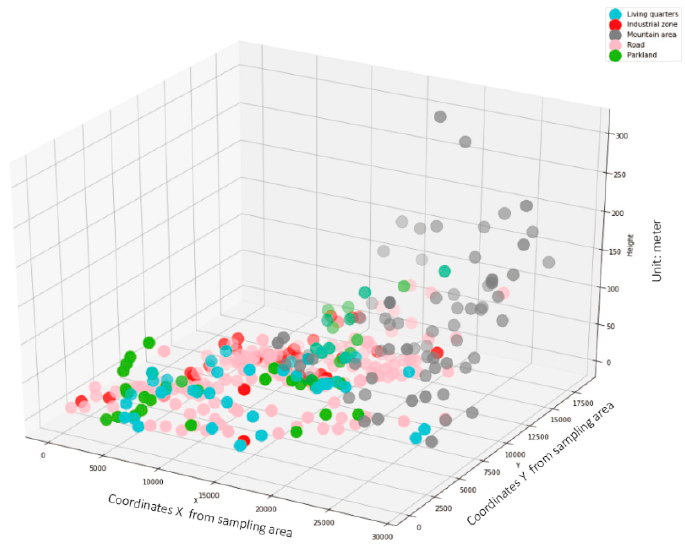
Figure 7. Distribution map of the urban functional areas.